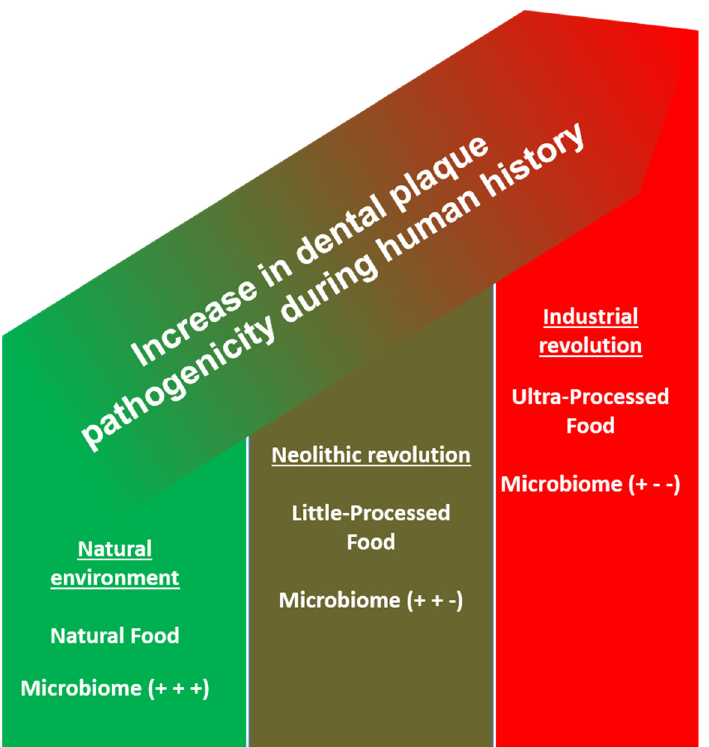
Figure 1. Scheme for the increase in plaque pathogenicity based on the drastic changes in human history. +, health-promoting; - disease-promoting. history. +, health-promoting; -